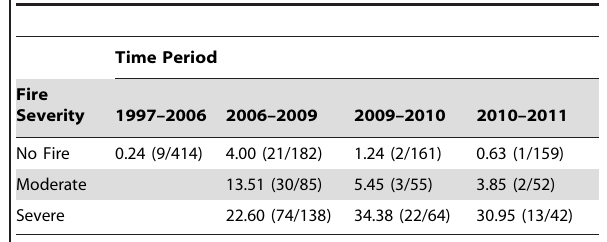
Table 2. Percentage rates of mortality of large cavity trees by fire category adjusted (standardized) for the duration of each measurement period.